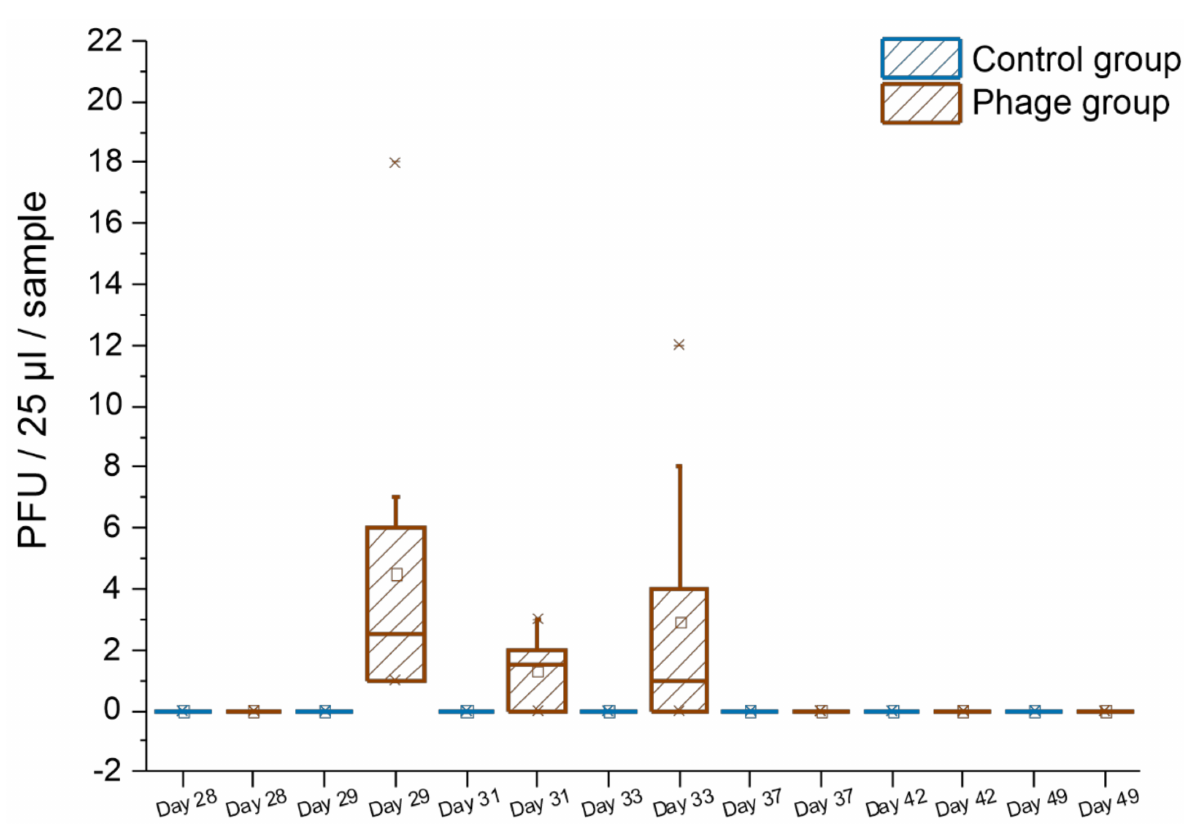
Figure 1. Number of phage PFUs in nasal and skin swab samples. For each nasal and swab sample, 25 µ L was analyzed for the presence of phages in S. aureus strains 13KP and 19A2 by the double-agar method. Plaques were only observed in strain 19A2. Square, horizontal line, box boundaries, vertical lines, and crosses indicate mean, median, upper and lower quartiles, upper and lower 95% values, and maximal and minimal values,